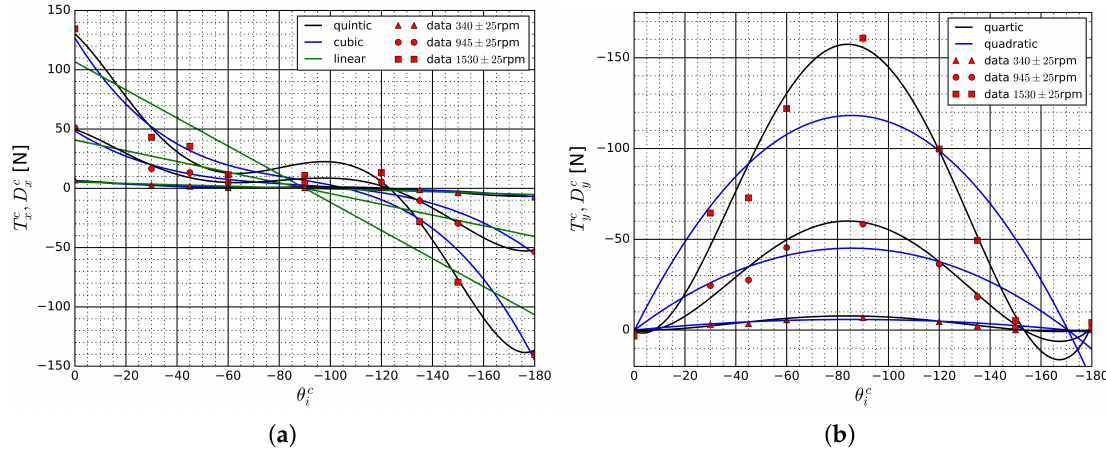
Figure 10. Exemplary model fits for ( a ) T c x and ( b ) T c y